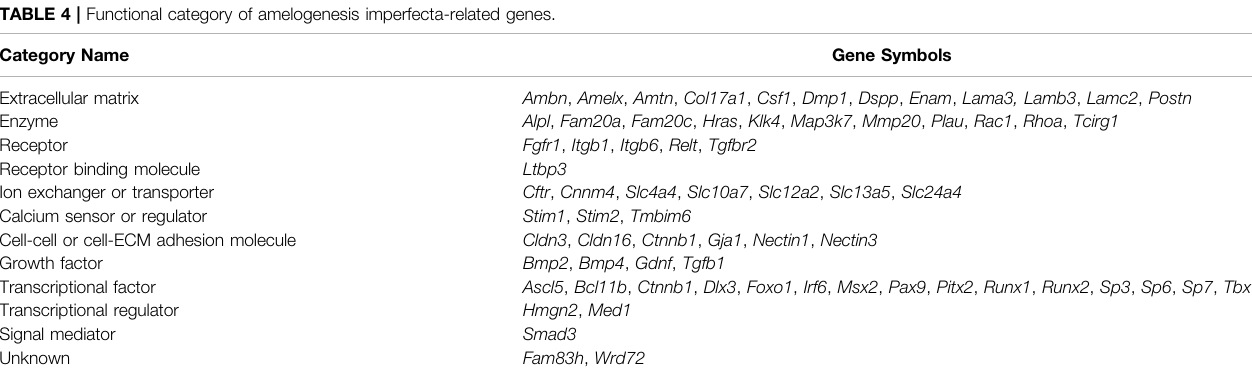
TABLE 4 | Functional category of amelogenesis imperfecta-related